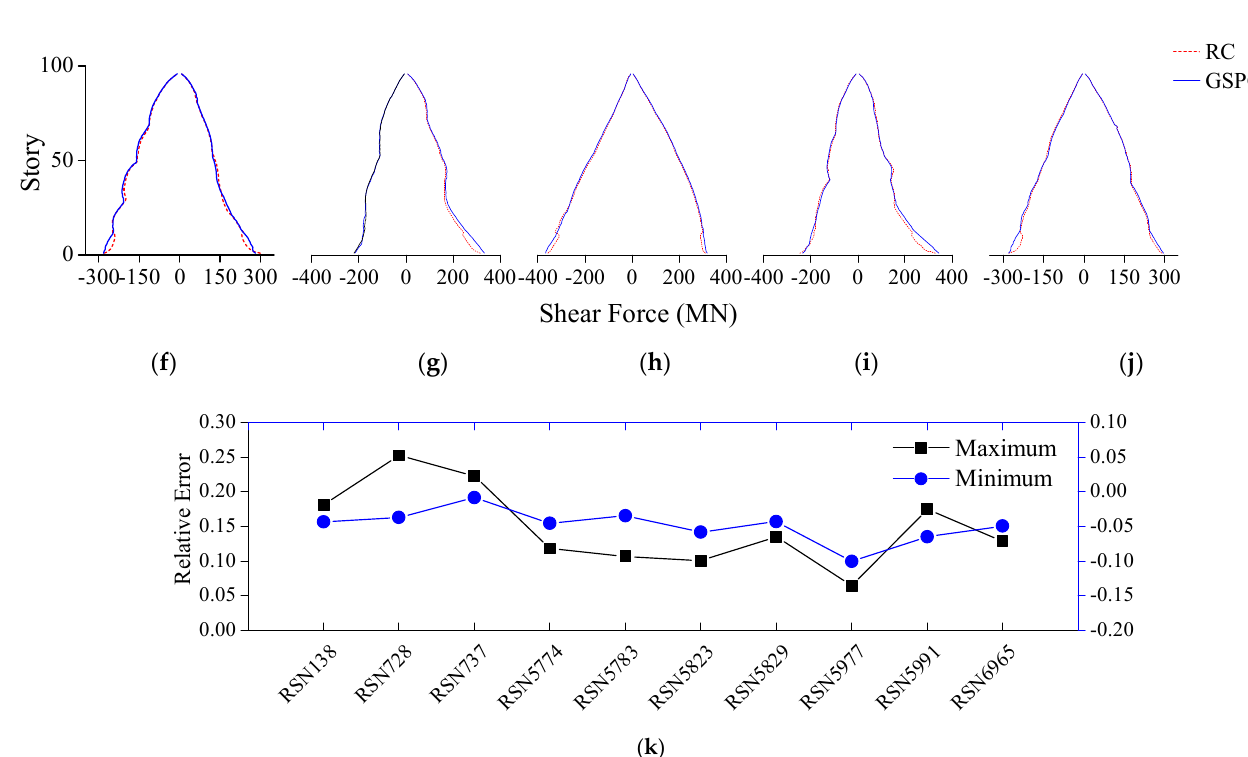
Figure 19. Comparison of story shear forces of each ground motion between RC and GSPCW models: ( a ) RSN138; ( b ) RSN728; ( c ) RSN737; ( d ) RSN5774; ( e ) RSN5783; ( f ) RSN5823; ( g ) RSN5829; ( h ) RSN5977; ( i ) RSN5991; ( j ) RSN6965; ( k ) Relative error.